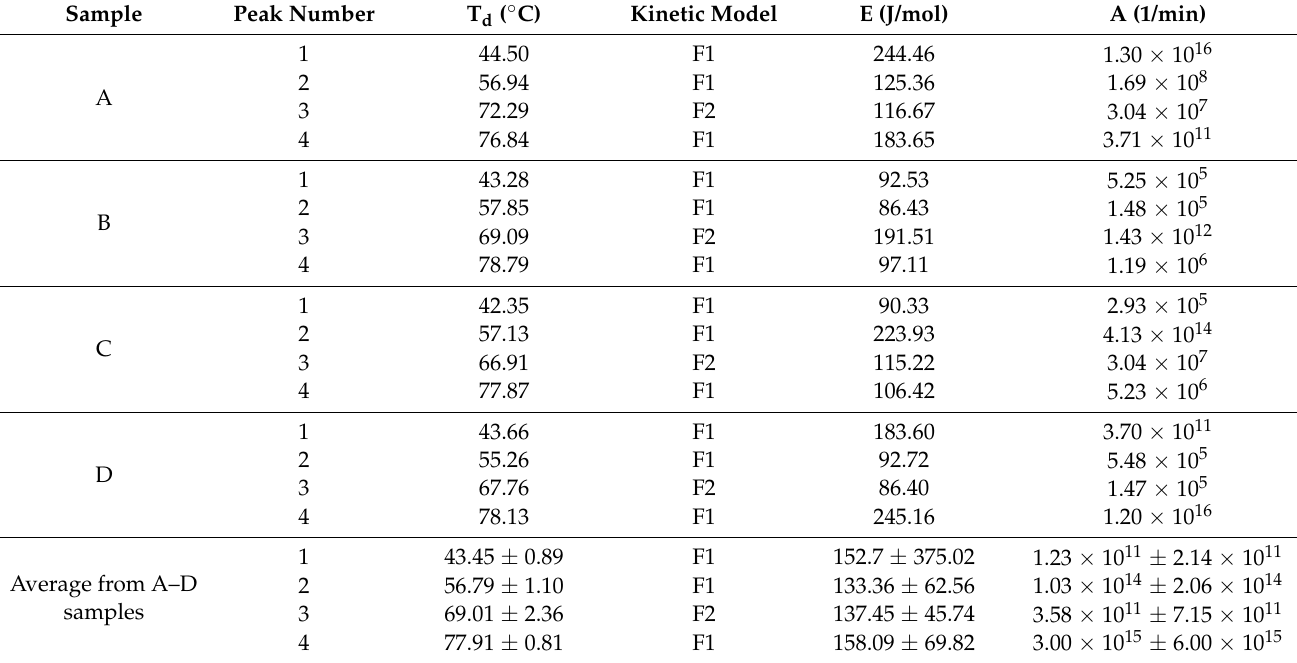
Table 2. Results of DSC analysis of Baltic herring muscle tissue ( n =